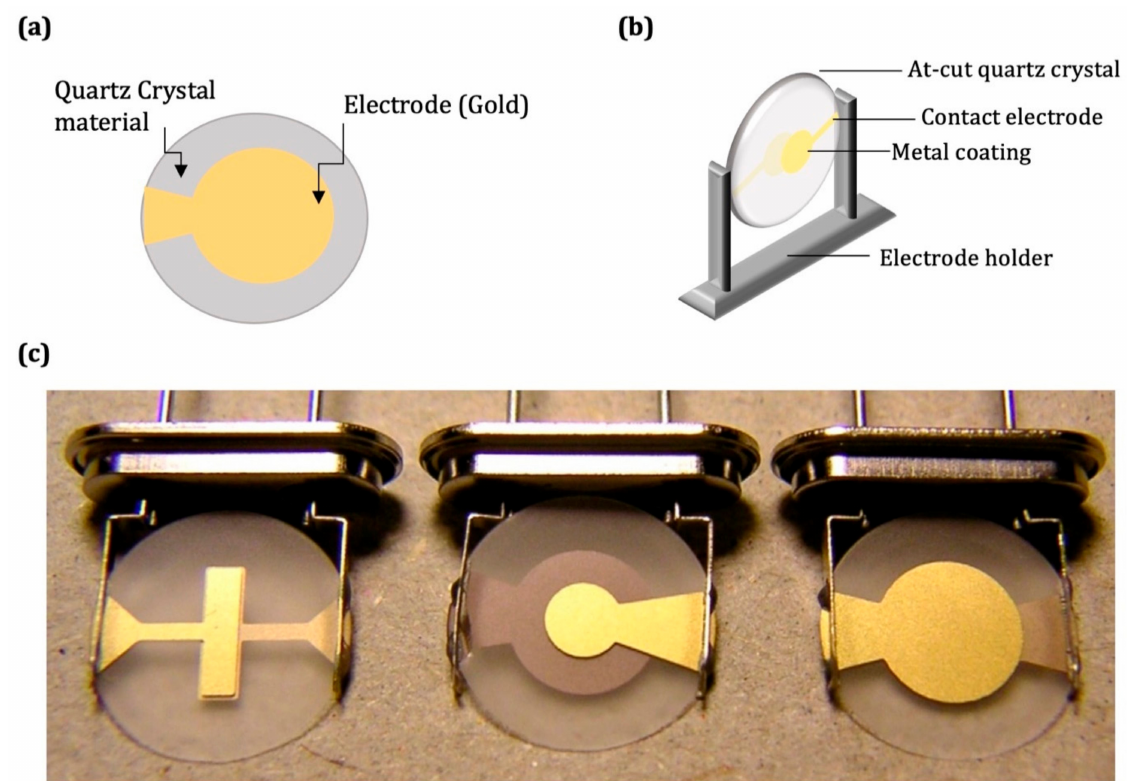
Figure 2. ( a ) The top view of the quartz crystal electrode; ( b ) AT-cut quartz crystal coated with gold; ( c ) quartz crystal photographs. Reprinted with permission from ref. [58]. Copyright 2007 Elsevier.